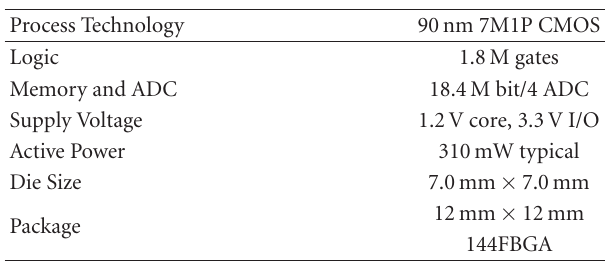
Table 5: Summary of